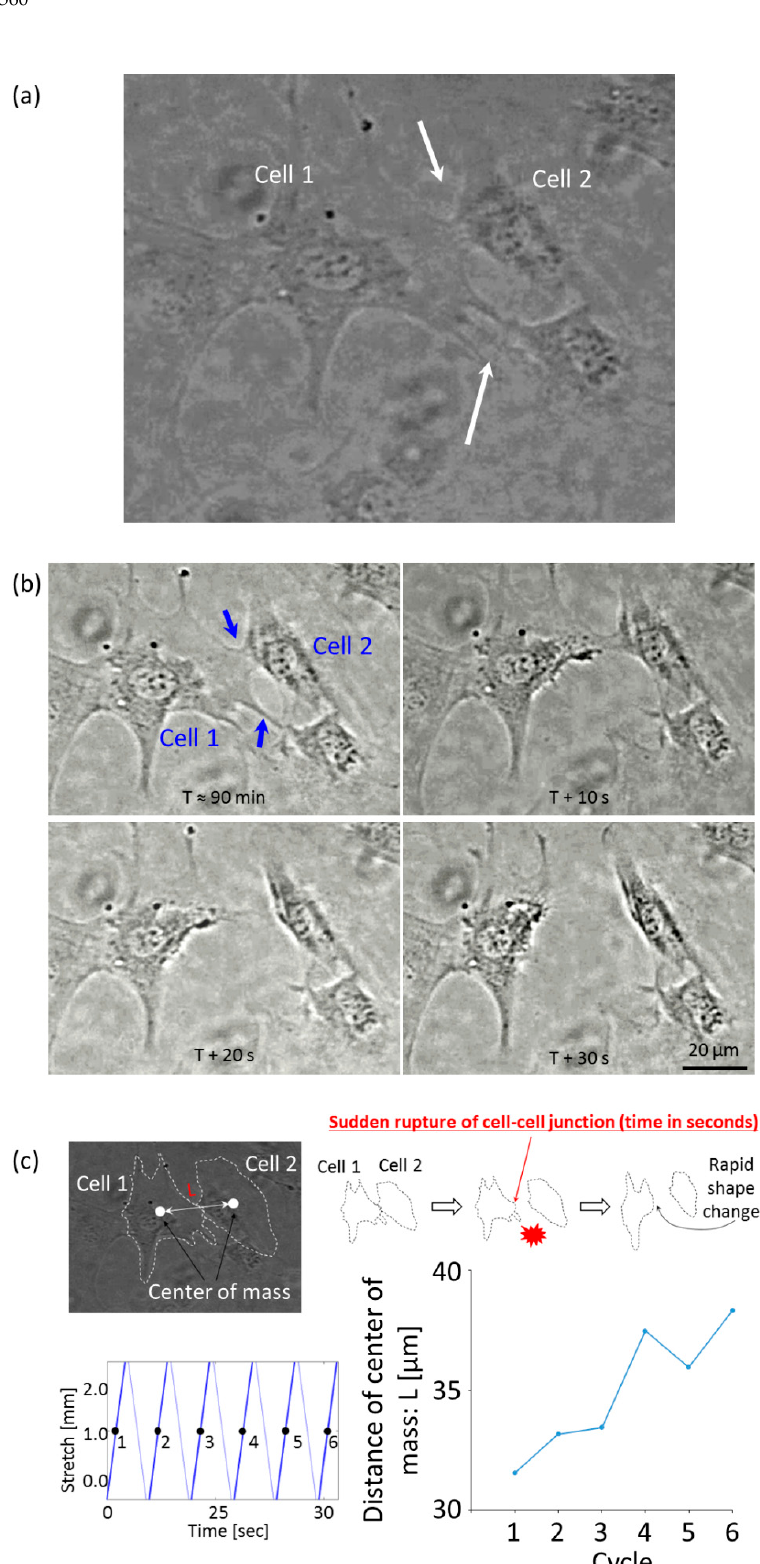
Figure 12. Analysis of the detailed cell change occurring suddenly from the real-time movie with 30 fps. ( a ) A cell–cell junction was observed before a sudden disruption between two cells. ( b ) Analysis of images in the middle of lengthening phases before and after the sudden disruption. The distance of the center of mass was used to demonstrate the drastic changes of cells induced by the disruption of the cell–cell junction. ( c ) Distance of the center of cells changed over a short period